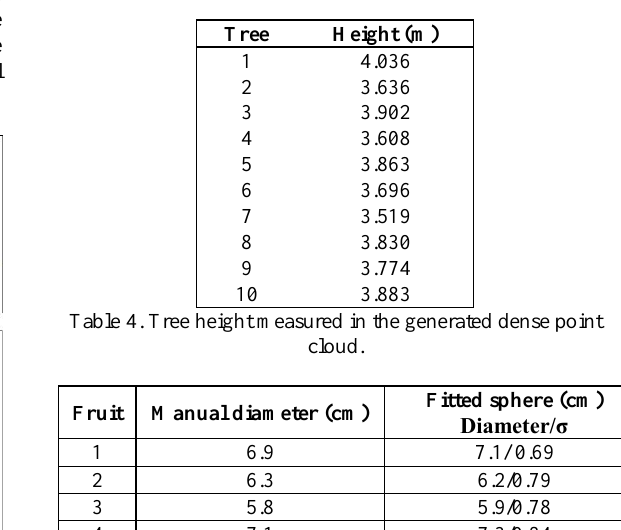
Figure 4. Examples of (a) a tree height measurement in the point cloud and (b) the 3D reconstruction of an orange fruit, the diameter measurement and the fitted sphere in CloudCompare.